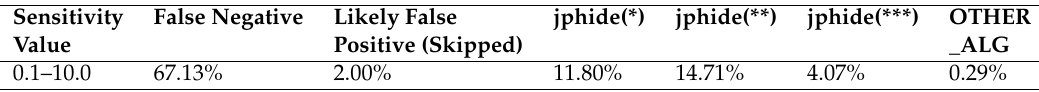
Table 1. Rate of sensitivity results from 500 images manipulated by seam-carve.